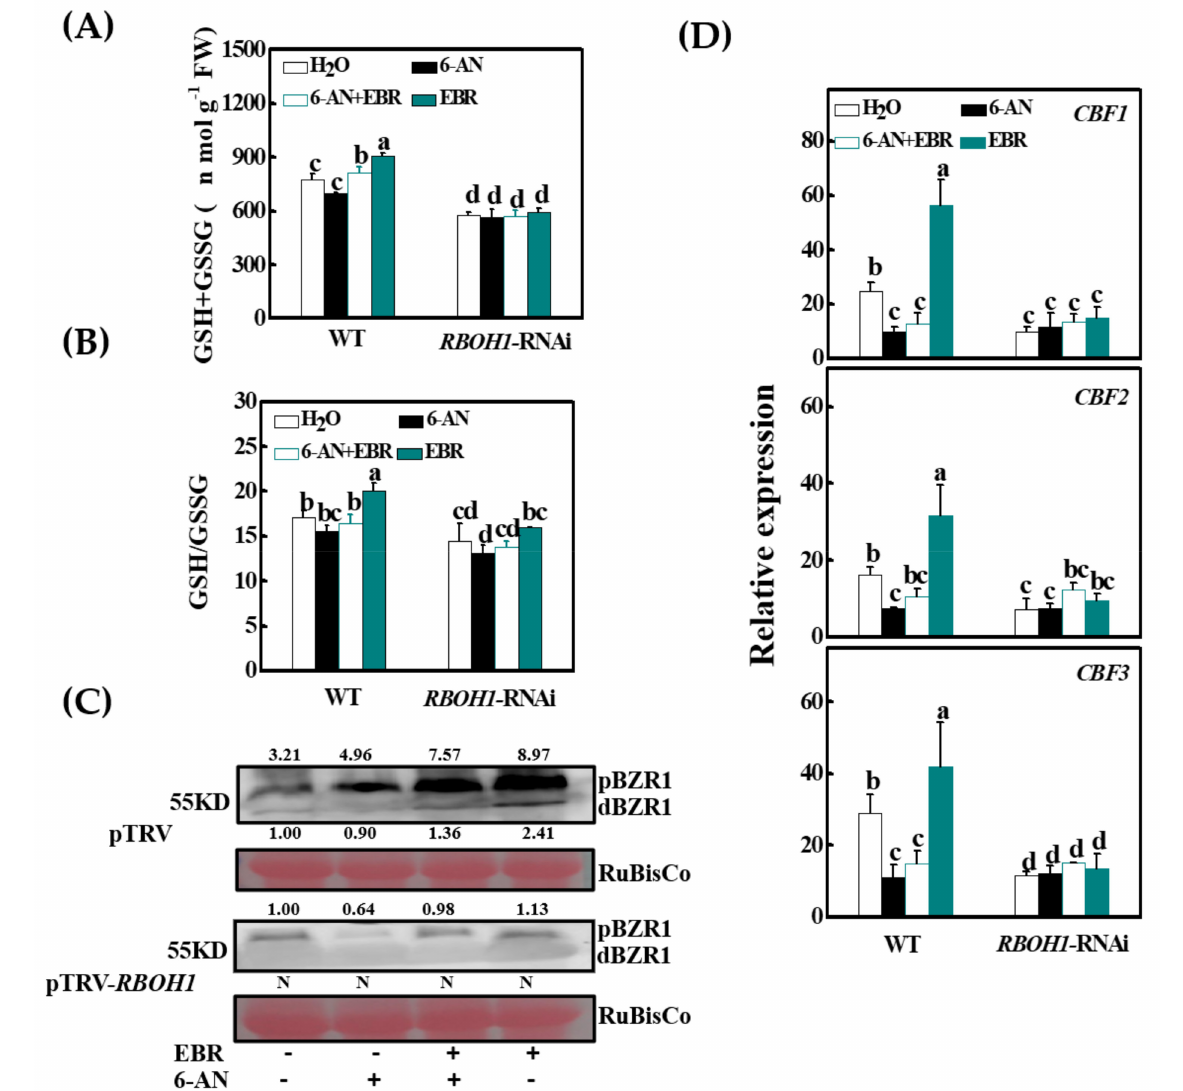
Figure 5. RBOH1 -regulated BZR1 accumulation is glutathione-homeostasis-dependent. ( A ) The total glutathione contents and ( B ) molar ratio of GSH/GSSG in wild-type (WT) and RBOH1 -RNAi plants exposed to 8 ◦ C for 12 h. ( C ) BR enhanced BZR1 abundance by the glutathione redox status regulation, and 35S:BZR1 -3HA-overexpressing ( BZR1 :OE) plants were used for VIGS. The control plants (pTRV) as well as the RBOH1 -silenced plants (pTRV- RBOH1 ) were foliar applied, respectively, with distilled water, 5 mM 6-aminonicotinamide (6-AN), 200 nM 24-epibrassinolide (EBR), or 5 mM 6-AN followed with 200 nM EBR for 24 h, and then subsequently exposed to cold at 8 ◦ C for another 12 h. The value above and below each lane indicates the relative accumulation of pBZR1 and dBZR1, respectively. N means none detected. ( D ) The relative expression of CBFs in WT and RBOH1 -RNAi plants exposed to 8 ◦ C for 8 h. Data are the means of three biological replicates ( ± SD) shown by vertical error bars. Different letters indicate significant differences according to Tukey’s test at 0.05% level. VIGS, virus-induced gene